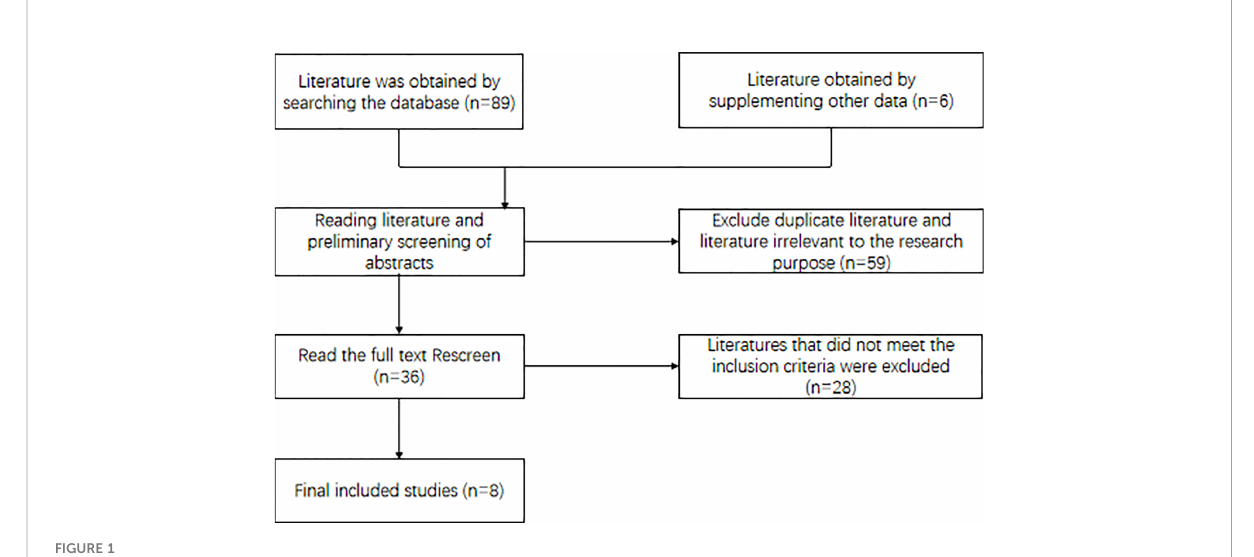
FIGURE 1 Literature retrieval process and